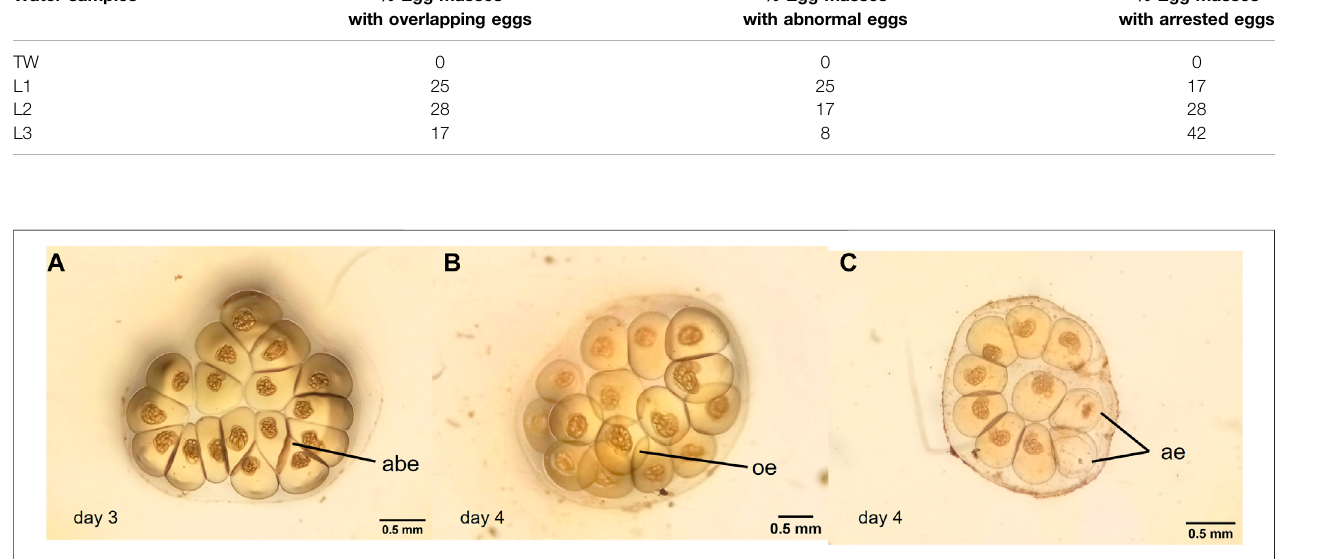
Frontiers in Physiology |